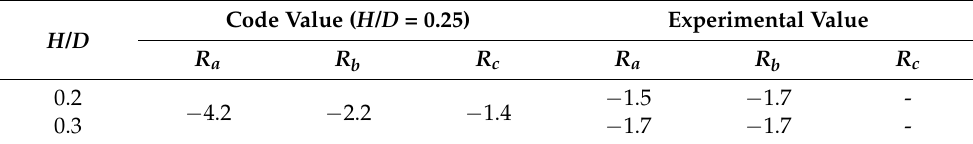
Table 9. Comparison of code value according to code area and C pn,max of open ratio = 30% [22]. Code Value ( H / D = 0.25) H / D